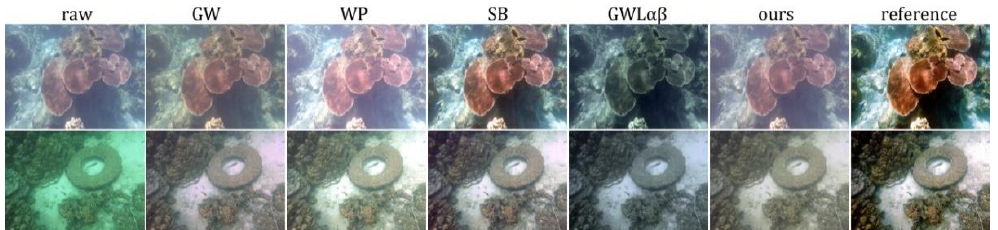
Figure 3. Comparisons on bluish and greenish underwater images. From left to right are raw underwater images, the results of gray-world (GW) method, white-patch (WP) method, statistical-based (SB) method [21], Bianco’s (GWLαβ) method [37], proposed method and reference images.